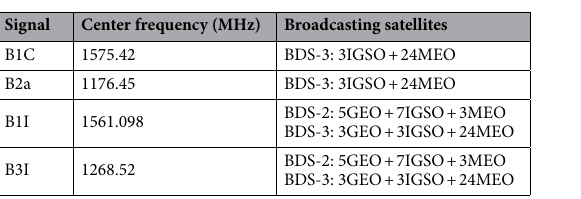
Table 2. Open service signals of BeiDou System. B1C and B2a are the new signals of BDS-3, while B1I and B3I are the compatible signals of both BDS-2 and BDS-3.